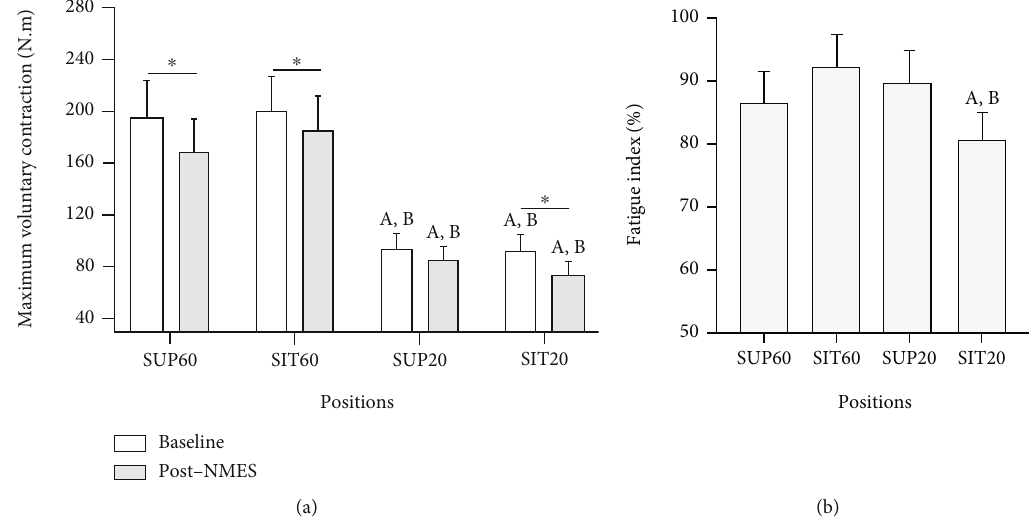
Figure 2: Maximum voluntary contraction in absolute (N.m; (a)) and relative (fatigue index [%]; (b)) values pre- (baseline) and post-NMES. Data are presented as mean and 95% CI. Abbreviations: SUP60: supine with knee fl exed at 60 ° ; SIT60: seated with knee fl exed at 60 ° ; SUP20: supine with knee fl exed at 20 ° ; SIT20: seated with knee fl exed at 20 ° . NMES: neuromuscular electrical stimulation. Statistically signi fi cant di ff erences: ∗ p < 0 : 05 vs. baseline; a p < 0 : 05 vs. SUP60; b p < 0 : 05 vs. SIT60; c p < 0 : 05 vs.